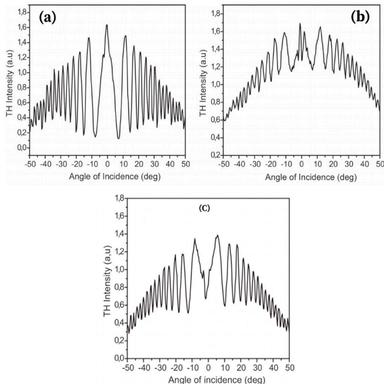
THG intensity from Sn doped NiO thin films prepared by spin-coating (with different / ratios: (a) pure NiO, (b) 1 at.% Sn and (c) 3 at.% Sn) as a function of incident angle for the S-polarization laser beam.